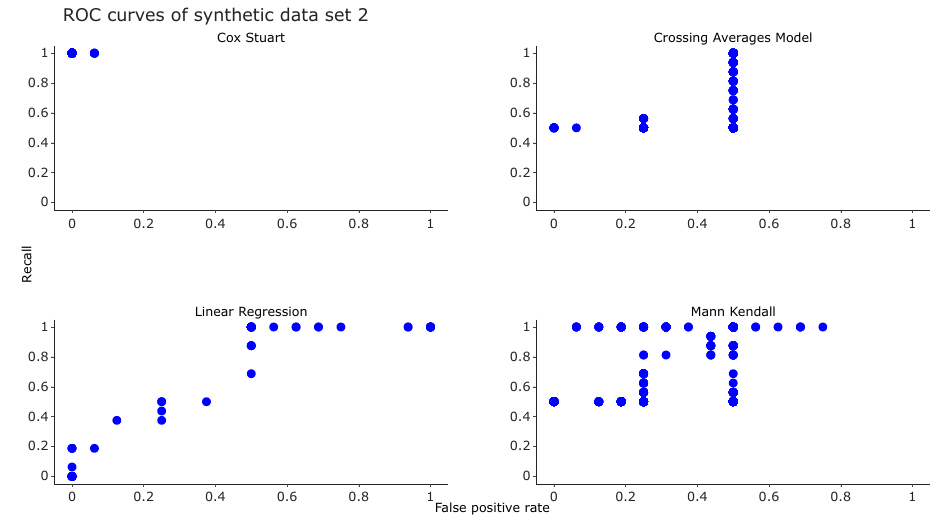
Figure 8. Trend detection model comparison based on the synthetic data set